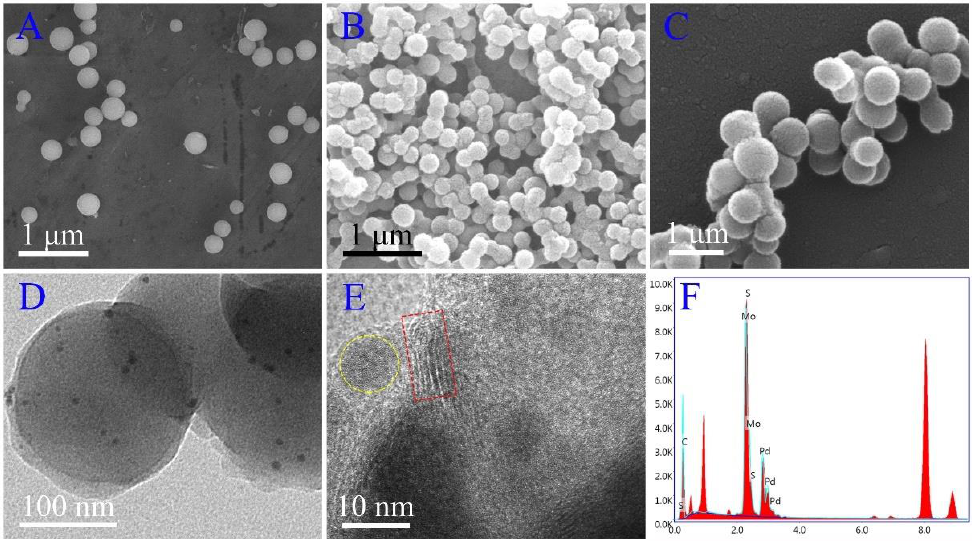
Figure 2. The SEM images of Cs ( A ), Cs@MoS 2 ( B ), and Cs@MoS 2 -Pd NPs ( C ). The TEM images of Cs@MoS 2 -Pd NPs ( D , E ) and their EDS images ( F ) .